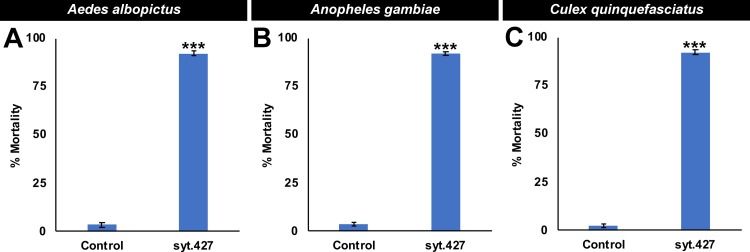
syt.427 is a broad-range mosquito larvicide.Consumption of syt.427 inactivated yeast interfering RNA larvicide tablets induces high levels of mortality in A. albopictus (A), A. gambiae (B), and C. quinquefasciatus (C) larvae. Results were compiled from multiple biological replicates on a total of 180 A. albopictus (A) 240 A. gambiae (B), and 240 C. quinquefasciatus (C) larvae per treatment. Data are represented as mean larval mortality, and error bars denote SEM. Data were evaluated with a t-test. *** = P<0.001 when compared with control-fed larvae.